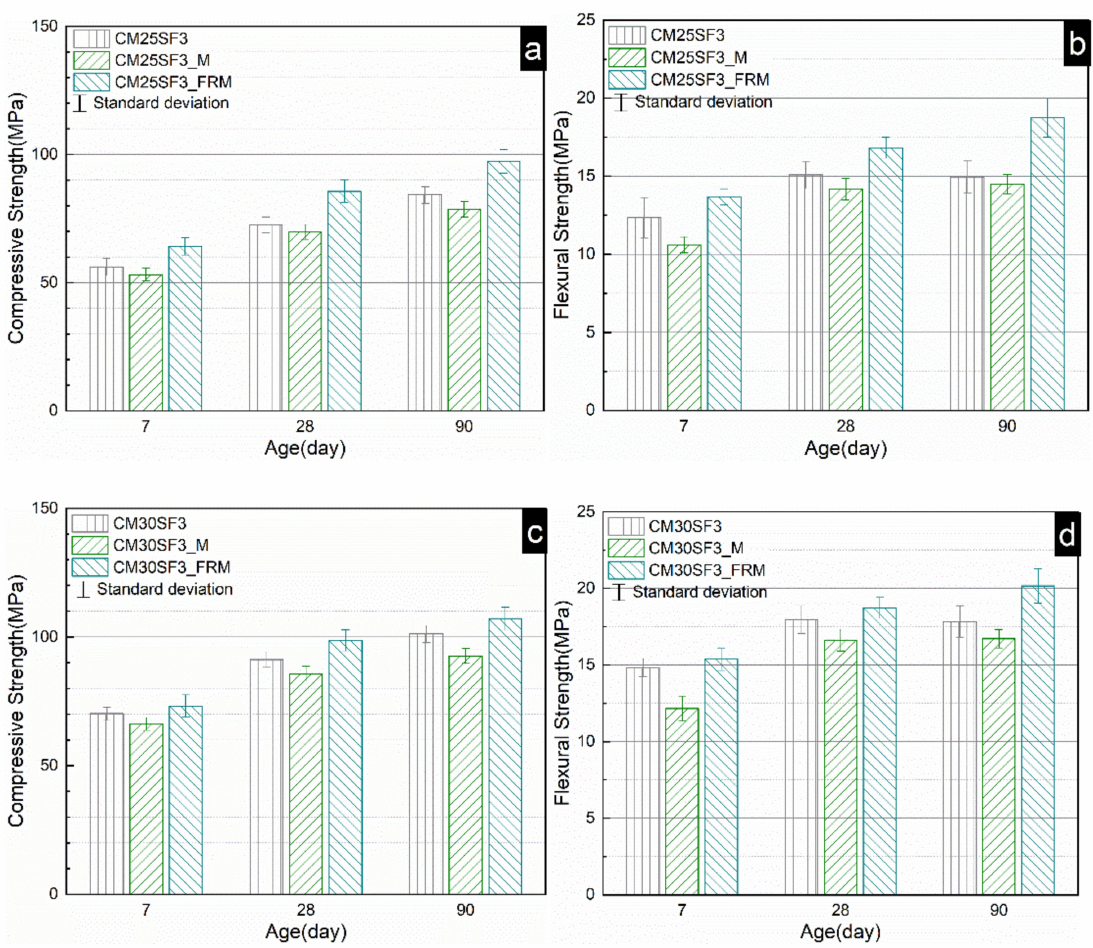
Figure 9. Compressive strength ( a , c ) and flexural strength ( b , d ) of paste, mortar, and fiber-reinforced reverse filling system. ( p = paste, M = mortar, FRM = fiber reinforcement